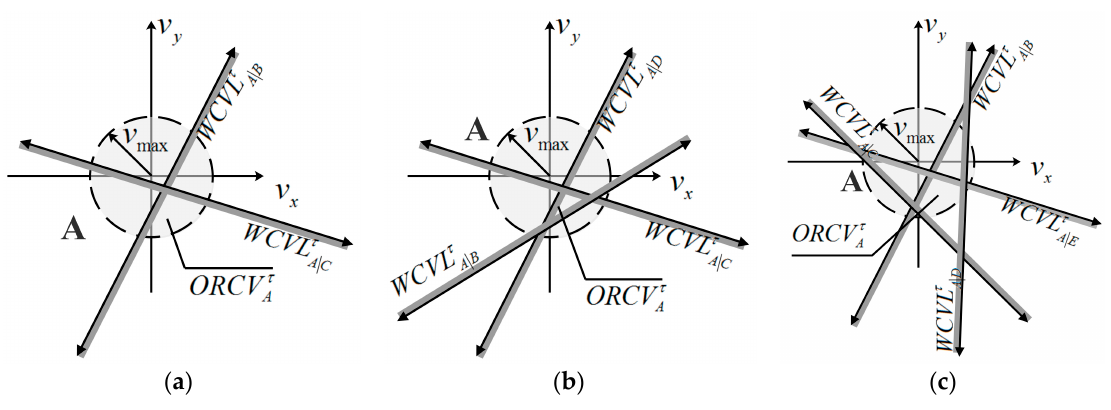
Figure 9. The error between the generated velocity and the optimal velocity.